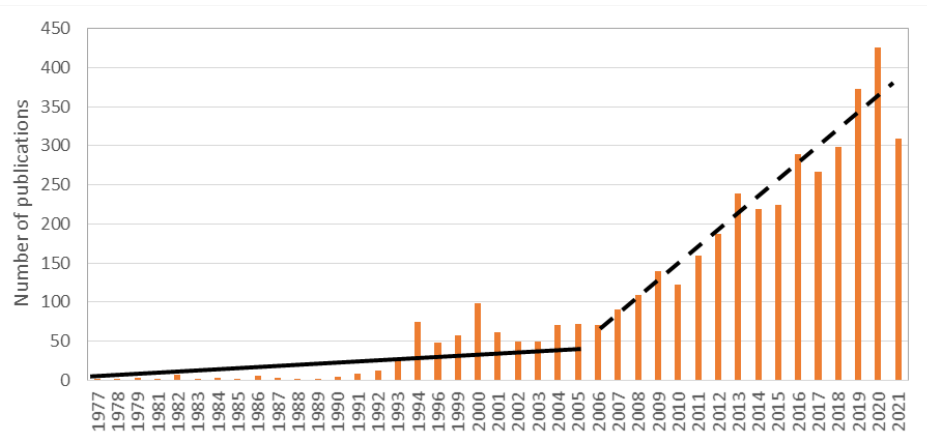
Figure 1. Number of publications issued yearly that concern mechanical processing of raw materials for the period 1977 –